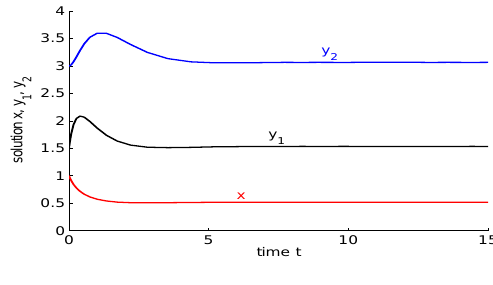
Figure 1: m = τ = 0 , E * = (0.5168, 1.5330, 3.0660) of system (1.4) is locally asymptotically stable.